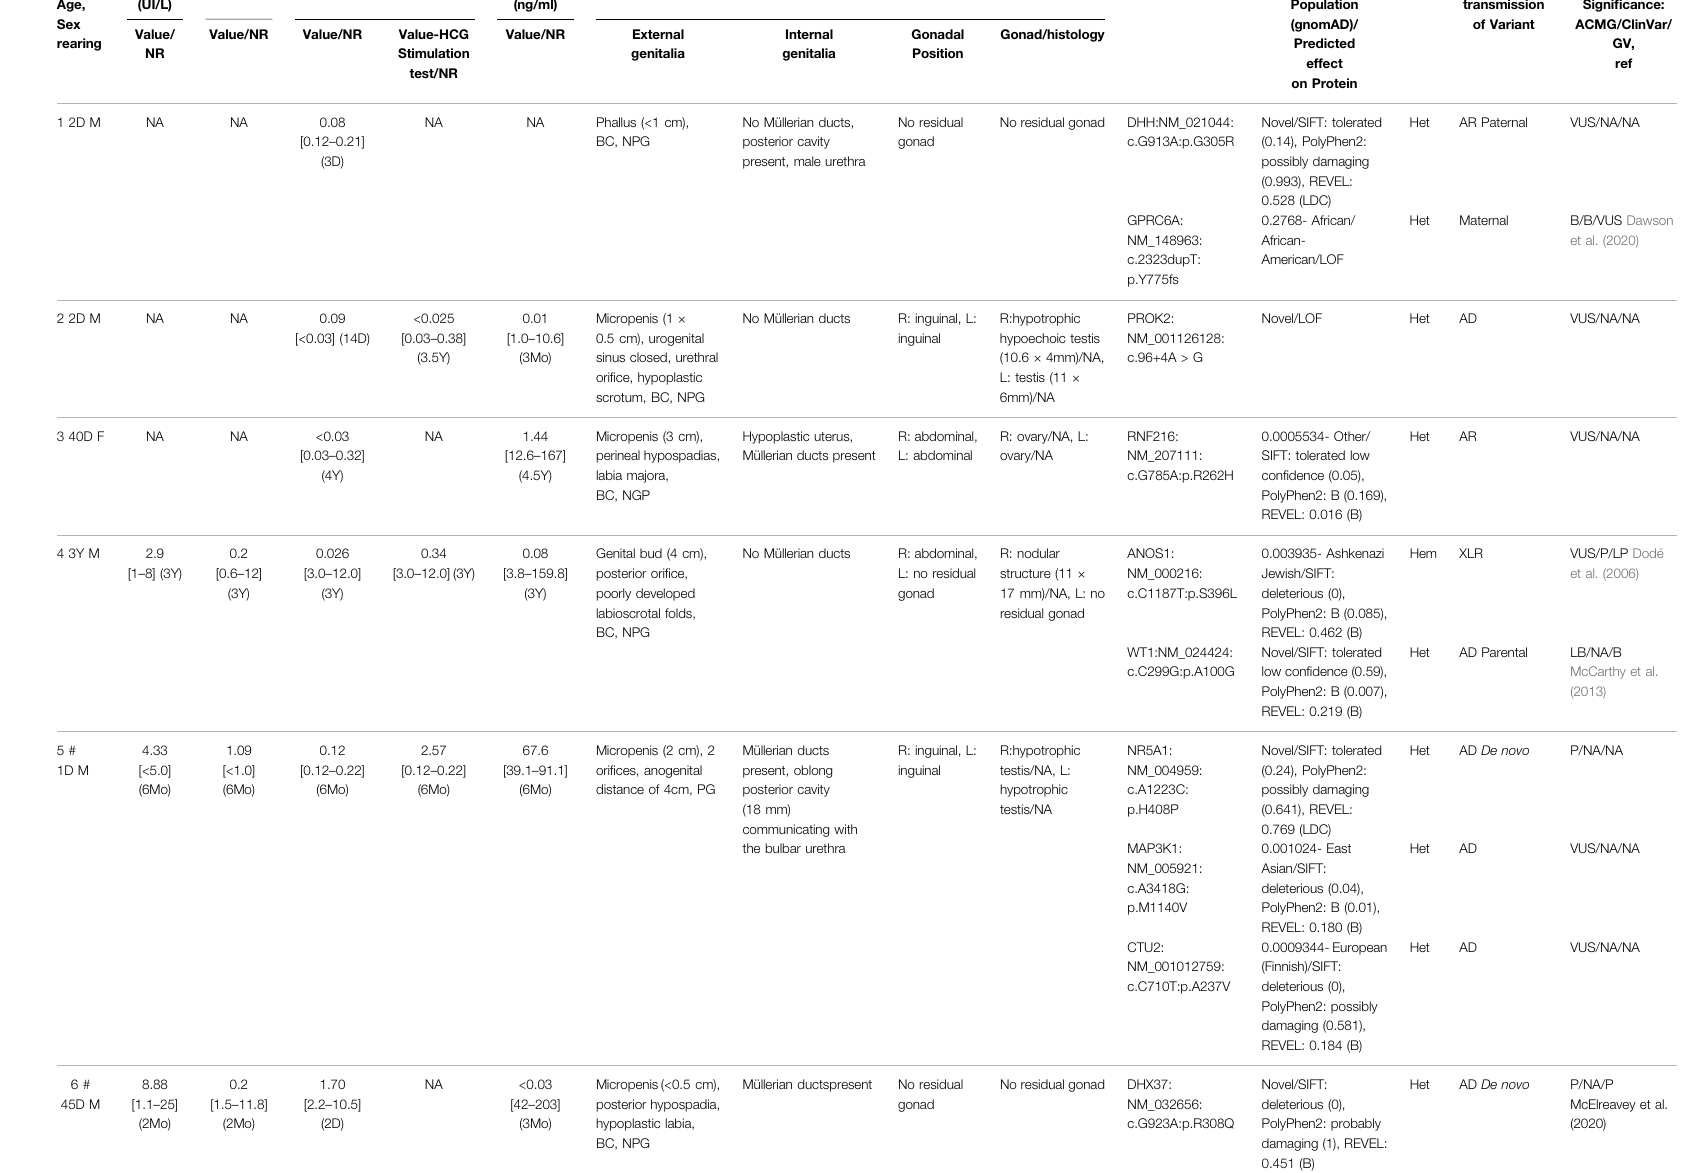
TABLE 2 | Clinical phenotype, hormonal pro fi le and details of variants identi fi ed in 12 individuals with disorders of gonadal development. Case,